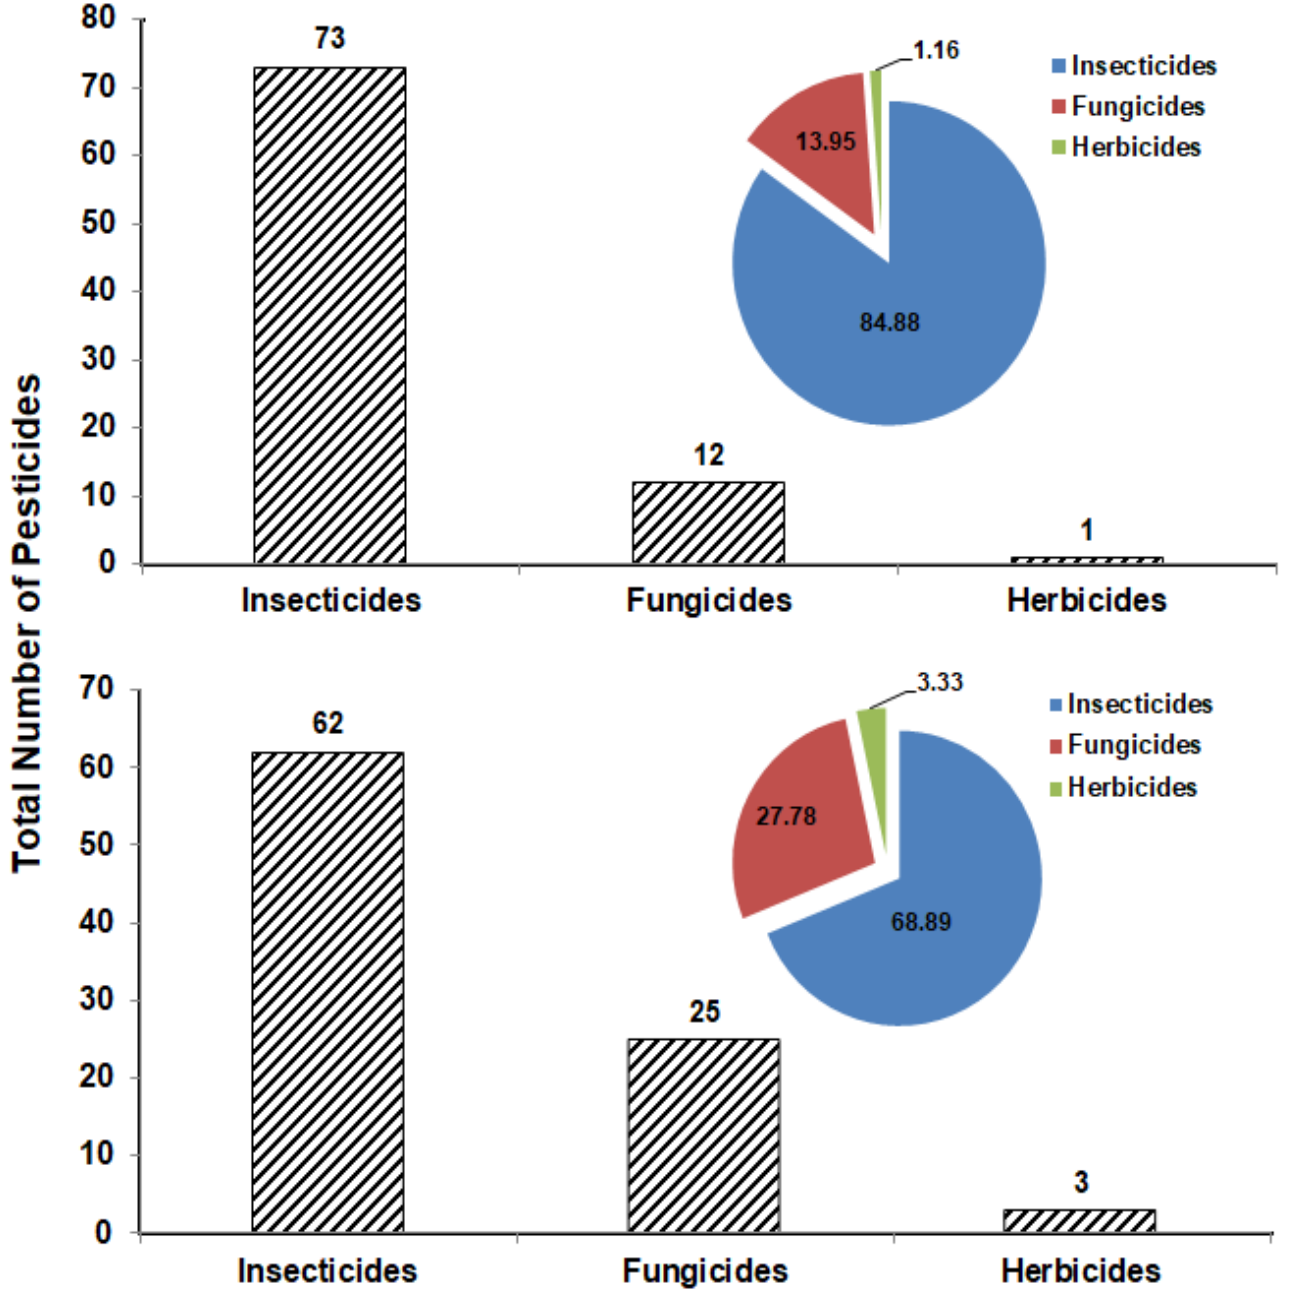
Figure 3. Total number of insecticides, fungicides, and herbicides and the frequency percentage detected in vegetable ( upper ) and fruit ( lower ) samples.